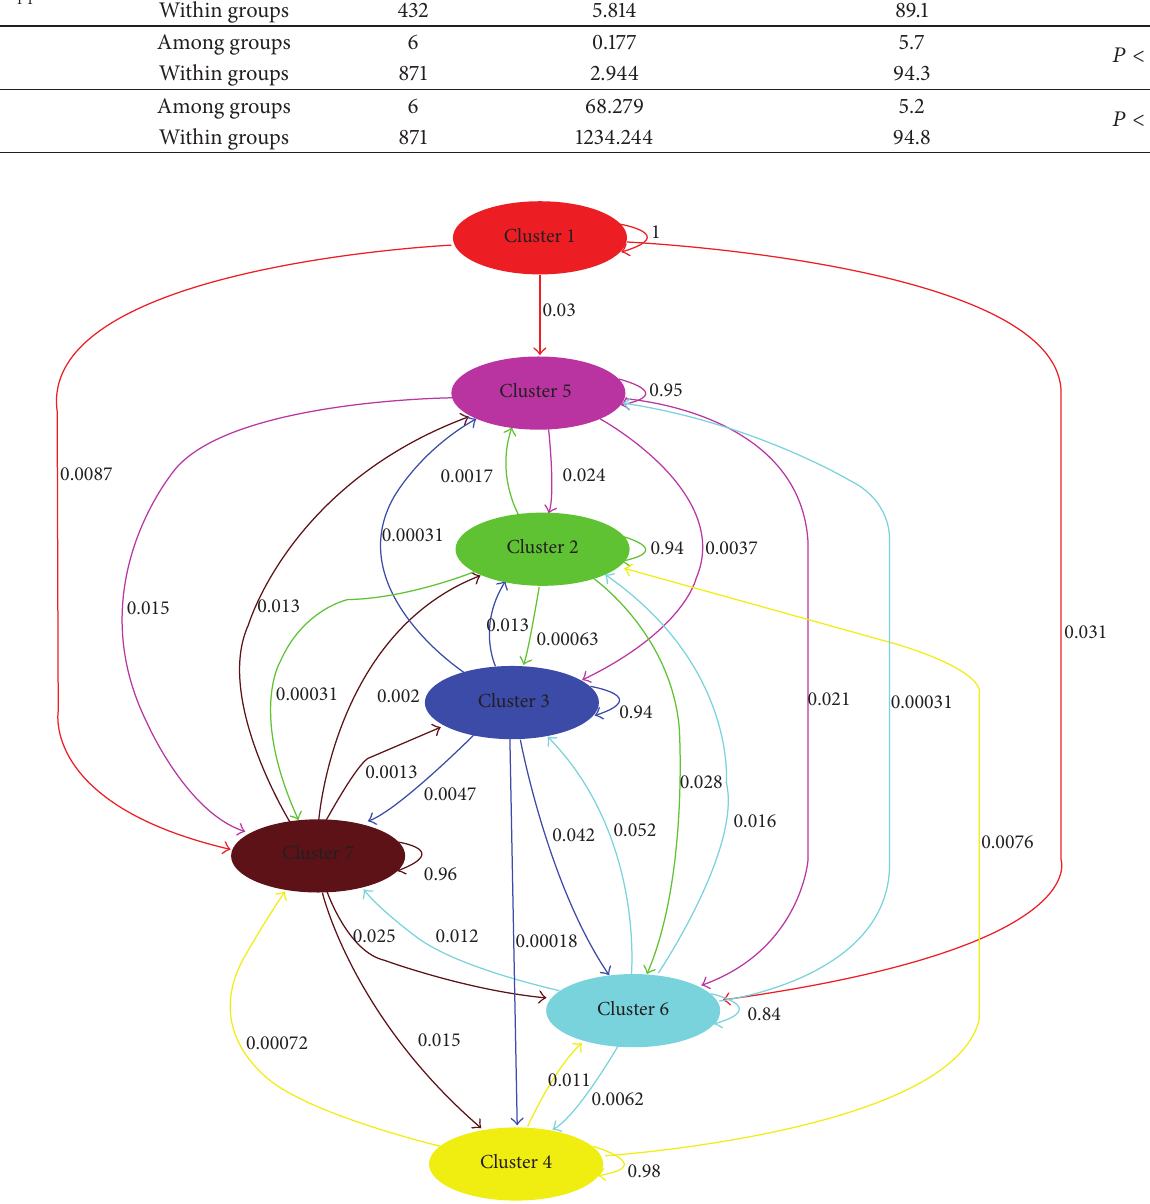
Figure 3: Main gene flows between clusters identified in Italian olive germplasm collection of CRA-OLI. In the graph, gene flows were shown by weighted arrows, so that the weights relative amounts of ancestry in the source cluster were assigned to the target